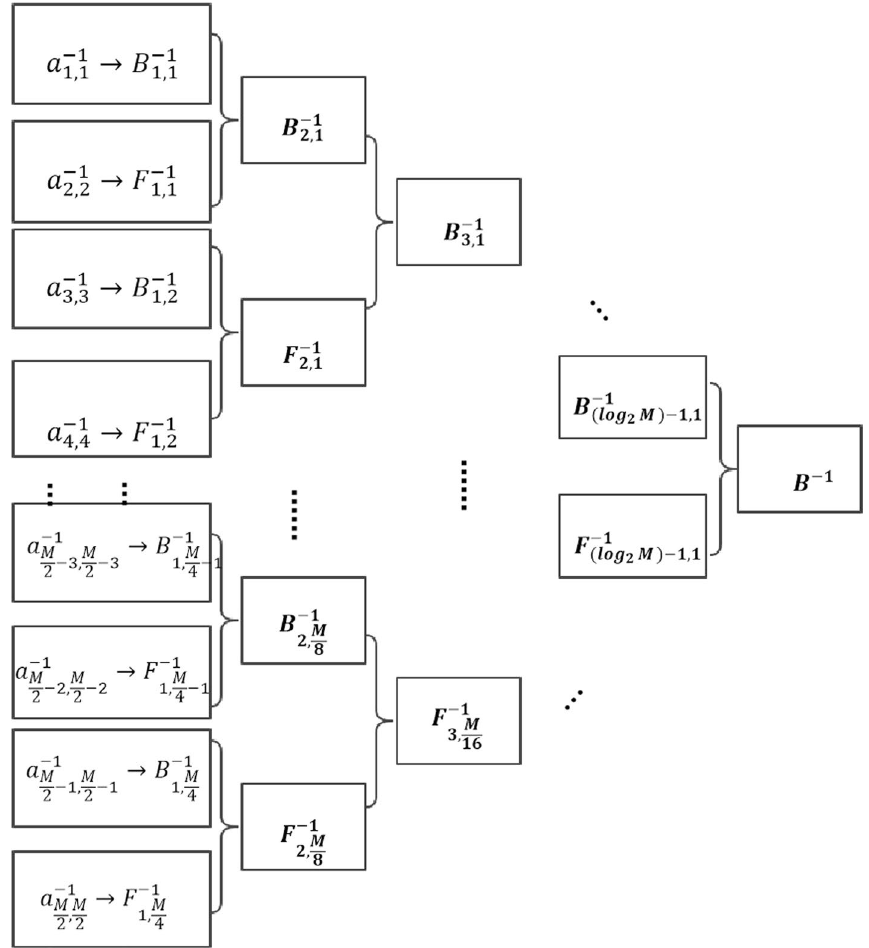
Fig. 8 Matrix solution for ( D + L ) −